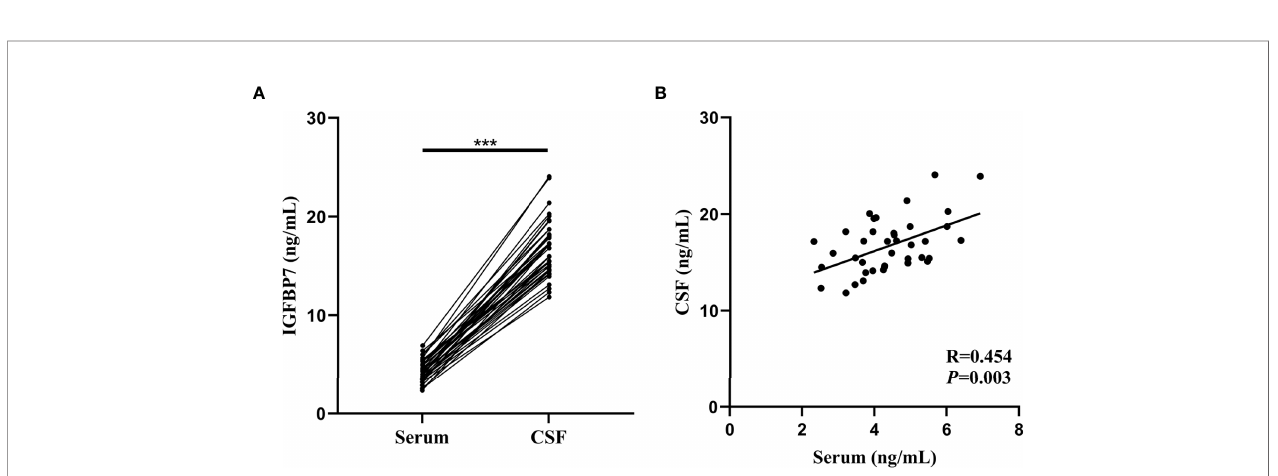
FIGURE 6 | Comparison and correlation between IGFBP7 in the serum and matched CSF of MS patients. (A) IGFBP7 measurements in CSF and matched serum samples collected from 40 patients. (B) Correlation plots between CSF and serum IFGBP7 in individual MS patients (n=40). Pearson ’ s correlation coef fi cients (R) and P-values are shown. Statistical signi fi cance was de fi ned as ***P < 0.001.